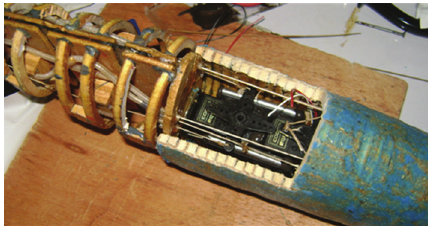
Figure 15: Cut view of the final